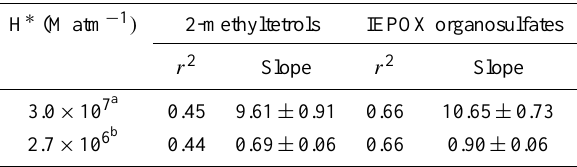
Table 3. Correlation ( r 2 ) of modeled SOA tracers with measure- ments.